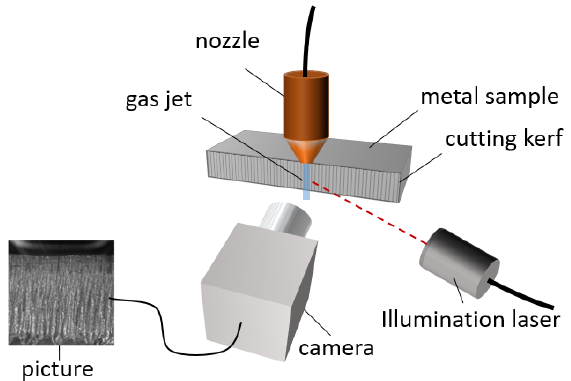
Figure 4. Setup for BOS of the gas jet from the nozzle. The setup consists of the cutting nozzle with its gas jet, which is observed; the cutting kerf of the metal sample acting as a background pattern in BOS; and a camera and illumination system.